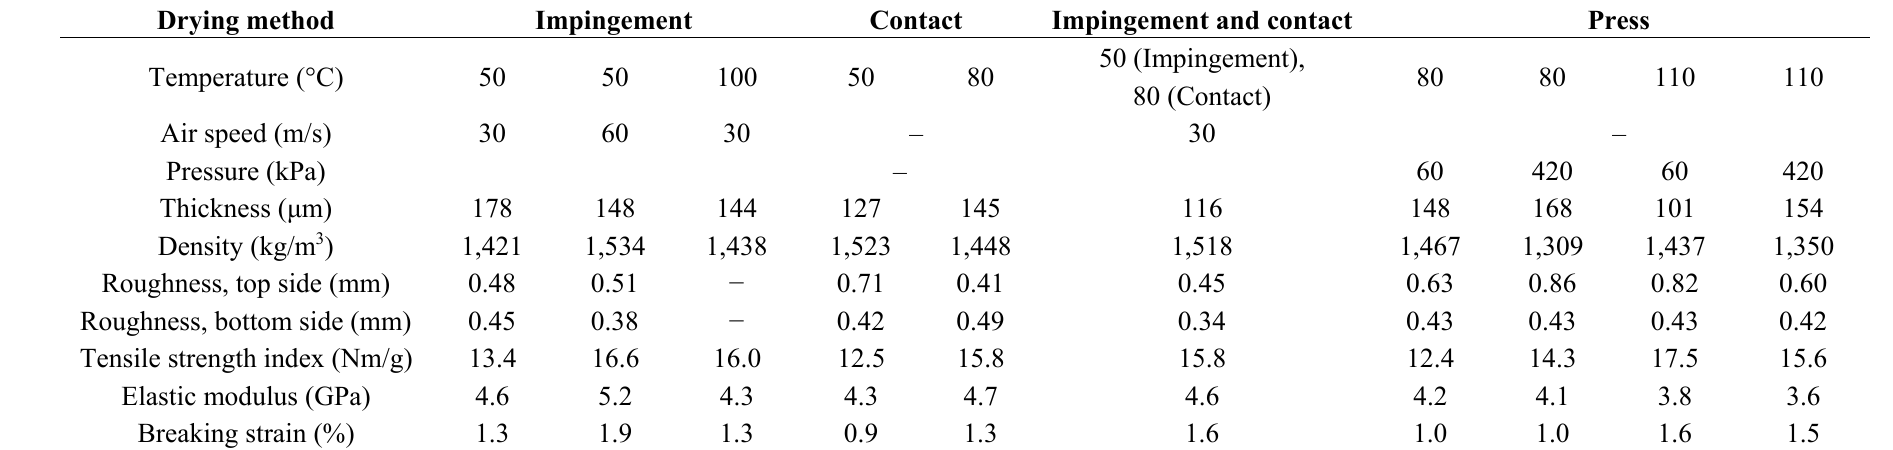
Table 1. Measured properties of the PCN substrates after